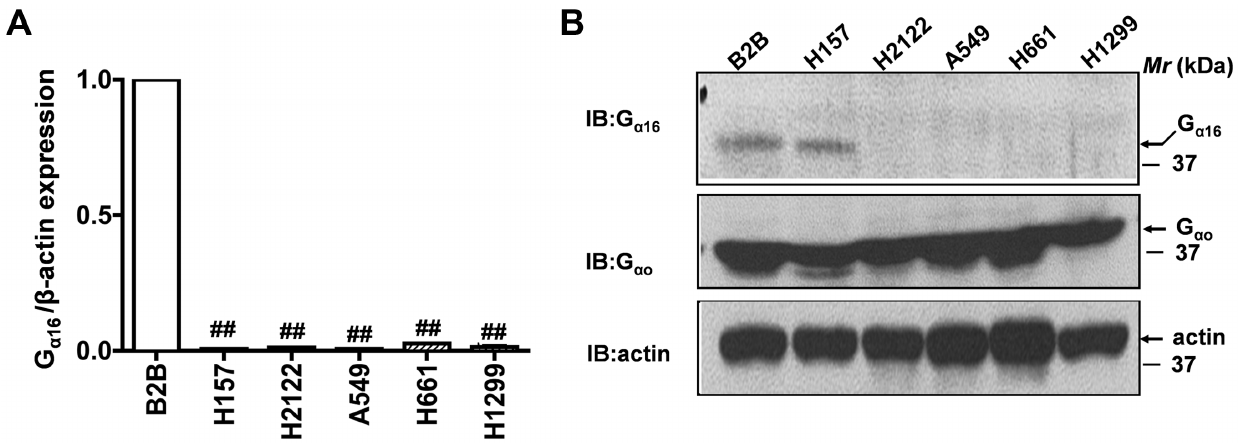
Figure 2. G a 16 expression is lost in NSCLC. A, Real-time PCR analyses of the expression of G a 16 in non-transformed and NSCLC cell lines. Total RNA was extracted from a non-transformed cell line (Beas2B) or NSCLC cell lines (H157, H2122, A549, H661 and H1299) and G a 16 expression was quantified using the sense: caccacgctagcctggtcatg and anti-sense: gcgcccttcttgctgccctcggg primers. b -actin was used as an internal control for normalization. Data represents mean 6 SEM of three separate experiments performed in duplicates. ## , p , 0.01; versus control (Beas2B). B, Western blot analysis of G a 16 expression in non-transformed and NSCLC cell lines. Equal amounts of total cell lysates of a non-transformed cell line (Beas2B) or NSCLC cell lines (H157, H2122, A549, H661 and H1299) were separated on a SDS-PAGE gels, transferred onto nitrocellulose blots and the ‘‘blots’’ were later probed with either anti-G a 16 , anti-G a o or anti- b -actin antibodies.